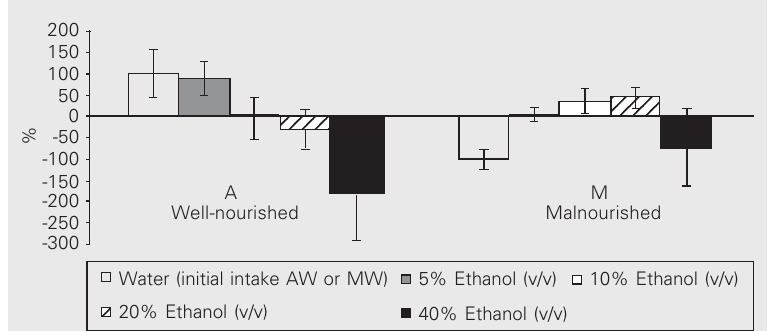
Figure 2. Effect of ethanol concentration in drinking water on weight gain during the well- nourished (A) and malnourished (M) phases. Data are reported as percent weight gain of the water group (AW and MW) rats; 100% = AW: 10.5 g and MW: -13.7